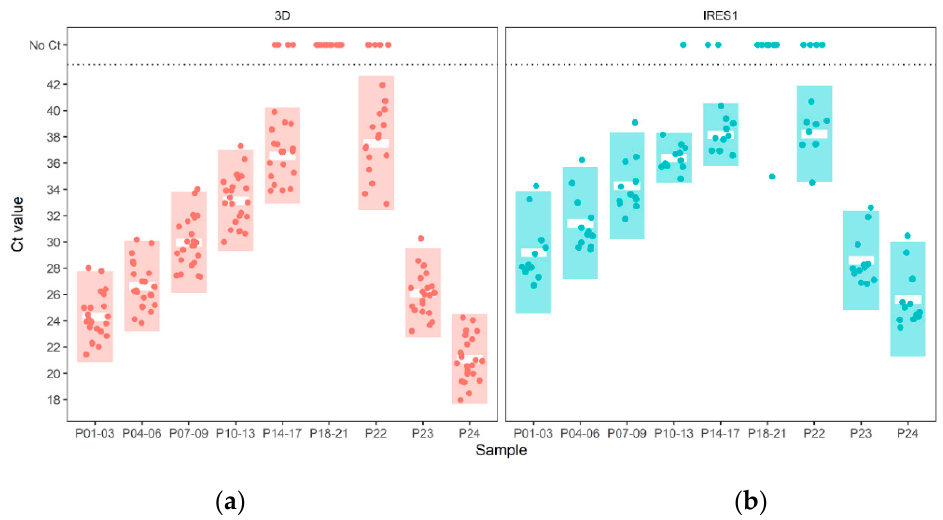
Figure 1. PCR results. The mean value of all results of each participant for a group of samples is shown as a single filled circle. The mean of means for all participants for each group of samples is represented by a white bar. The colored columns indicate the twofold standard deviation of the mean of means. ( a ) 3D-OIE assay; ( b ) IRES1 assay. See Table S1 in the Supplemental Material for the raw data summarized in this figure.